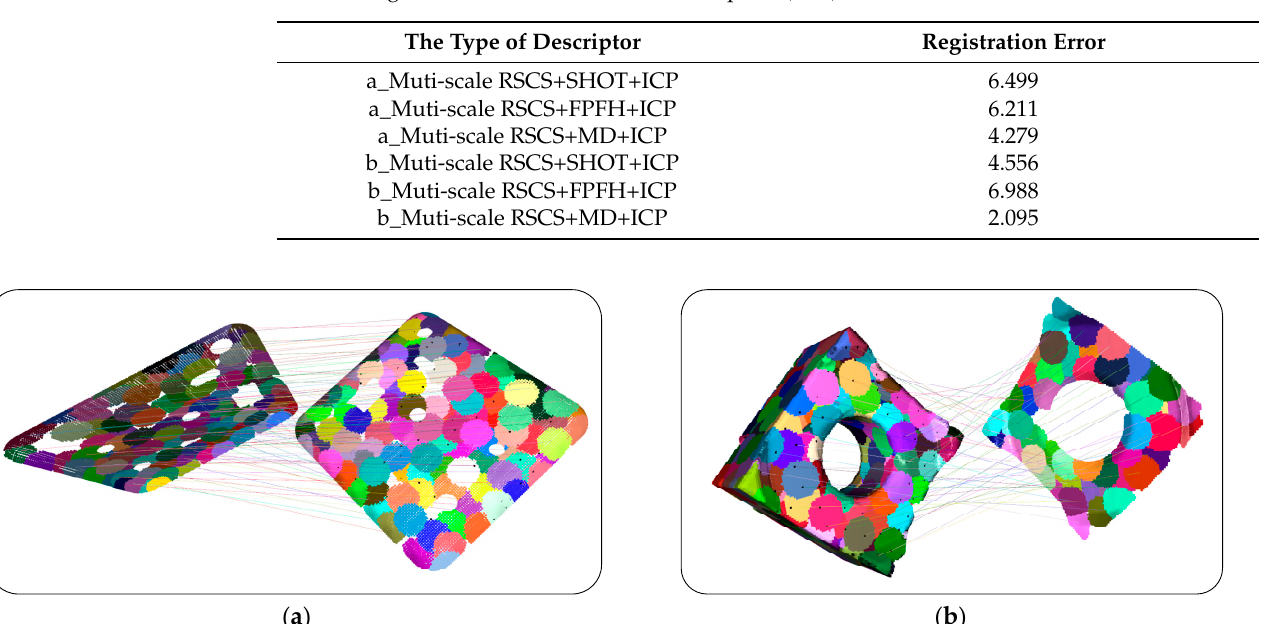
Figure 16. Results of different registration schemes for part 2: ( a ) coarse registration; ( b ) fine regis- tration. Table 2. Registration errors of different descriptors (mm).